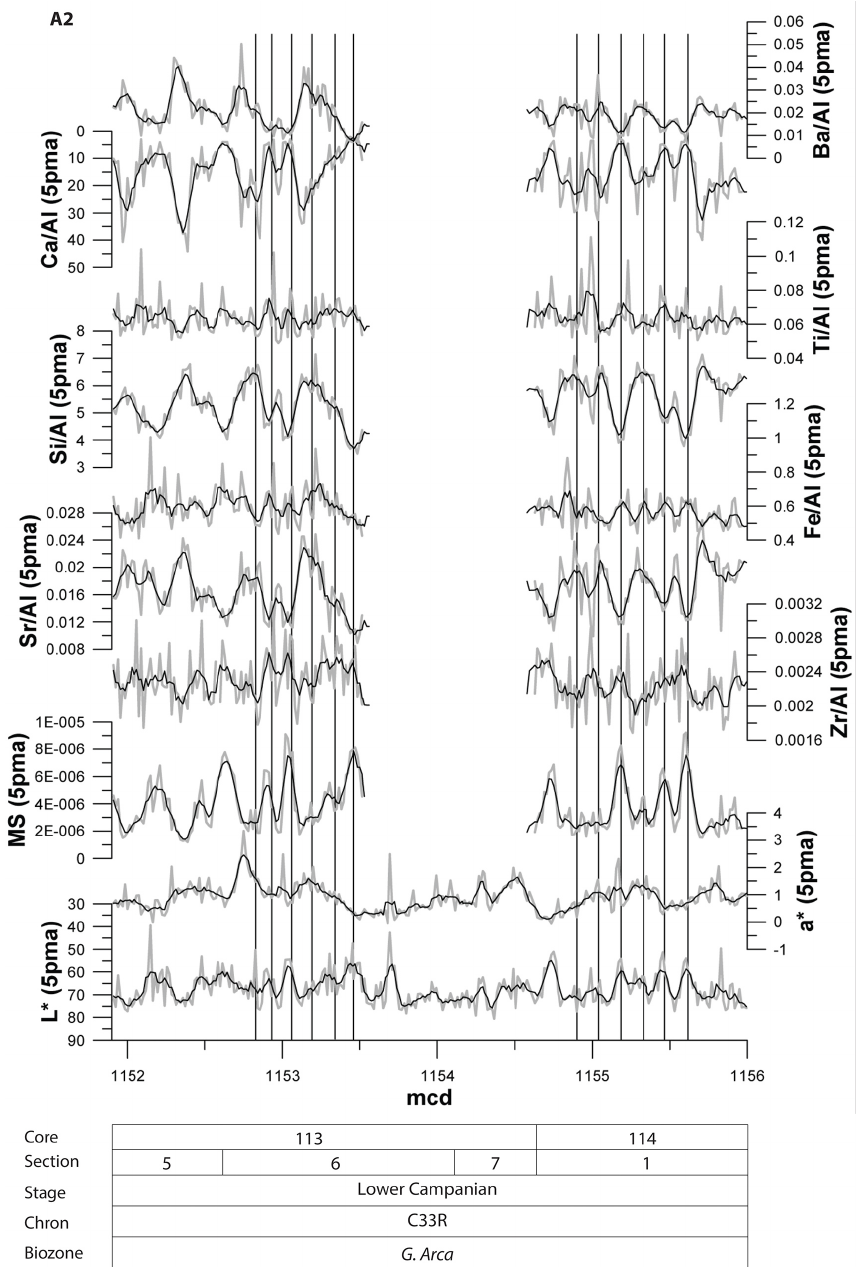
Figure A2. L ∗ , a ∗ , MS and all XRF elemental abundances divided by Al with 5 pma’s plotted against depth. The panel below shows the stratigraphic position of the studied interval and which core sections were